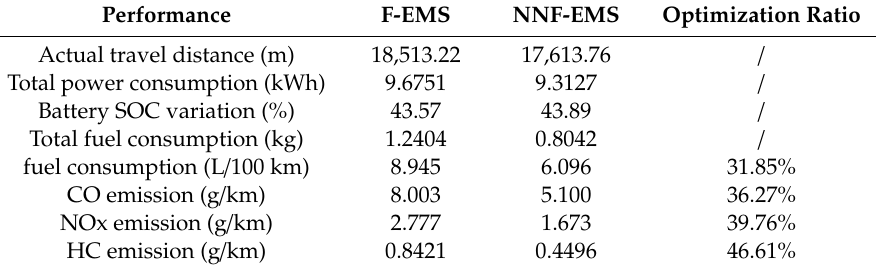
Table 4. Comparison of fuel economy and emission performance under FTP75 cycles.